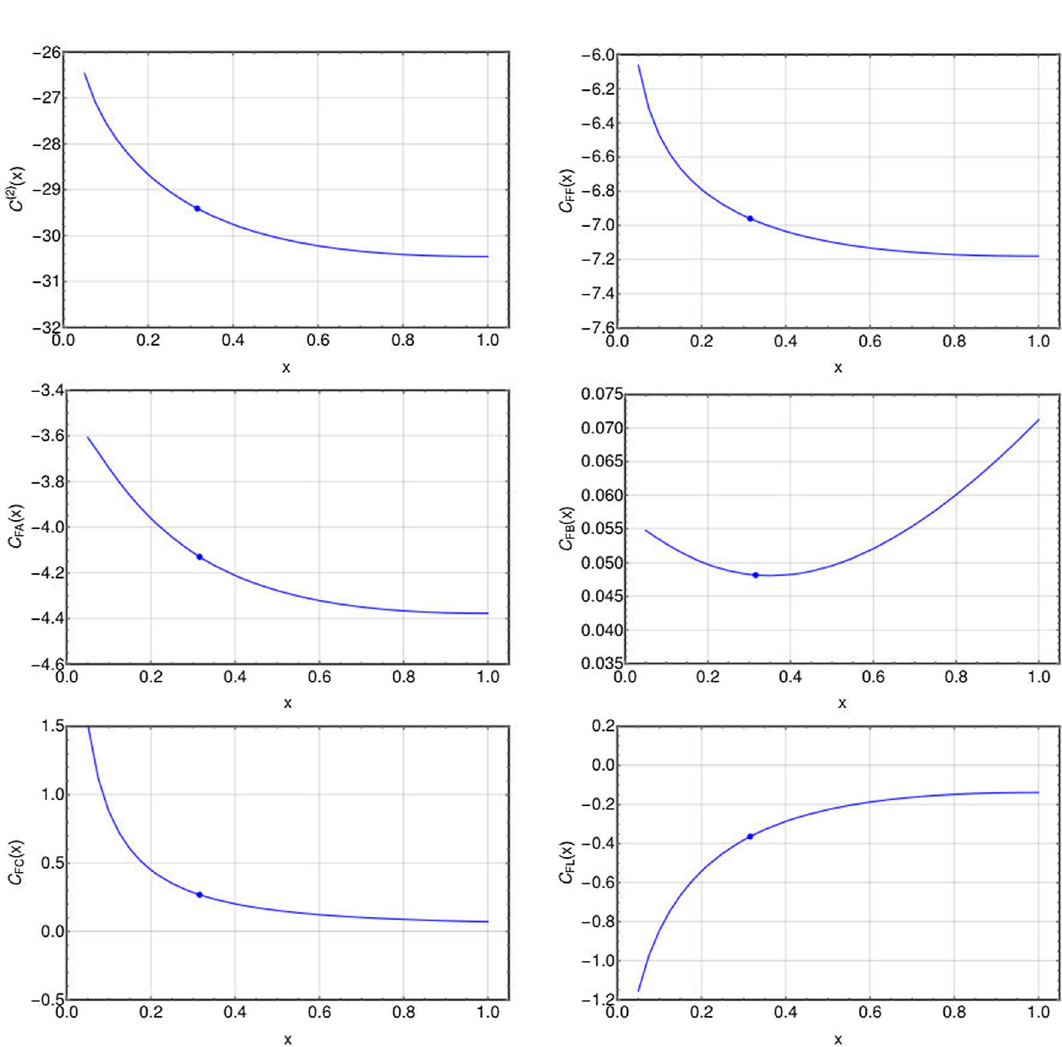
Fig. 3 The theoretical predictions of the two-loop coefficient C ( 2 ) ( x ) with n l = 3 , n c = n b = 1 and the five color-structure components as functions of the ratio x within the range of x = [ 0 . 05 , 1 ] . The solid points on the curves show the results at the physics point x